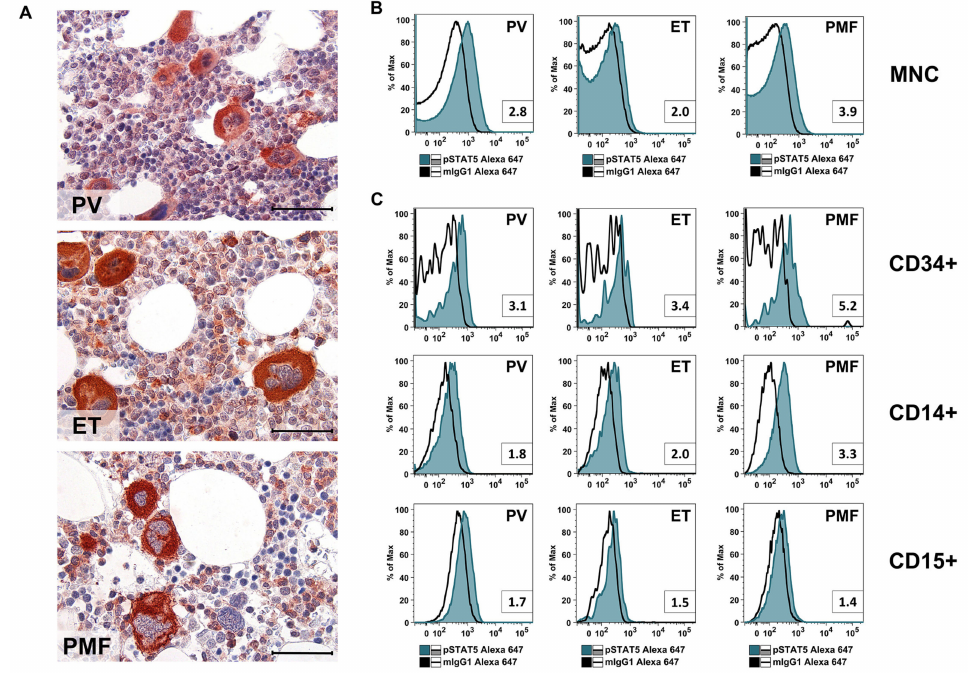
Figure 1. ( A ) Sections prepared from para ffi n-embedded bone marrow (iliac crest) of patients with polycythemia vera (PV; patient #06), essential thrombocythemia (ET; patient #34) or